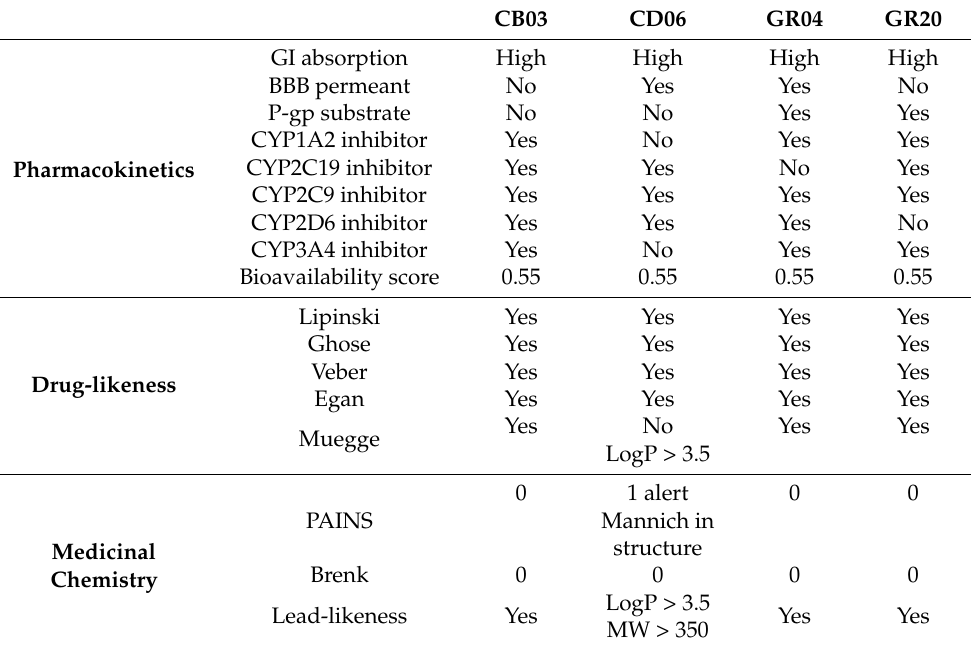
Table 1. Pharmacokinetics, drug-like, and lead-like characteristics of selected hits predicted by